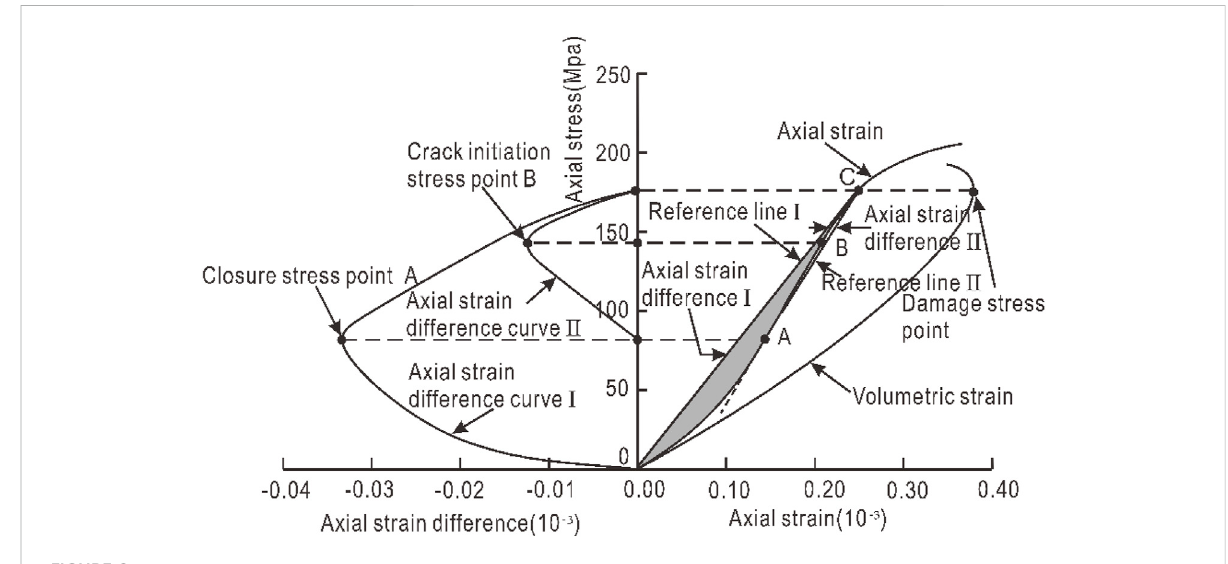
FIGURE 8 Schematic diagram of empirical value